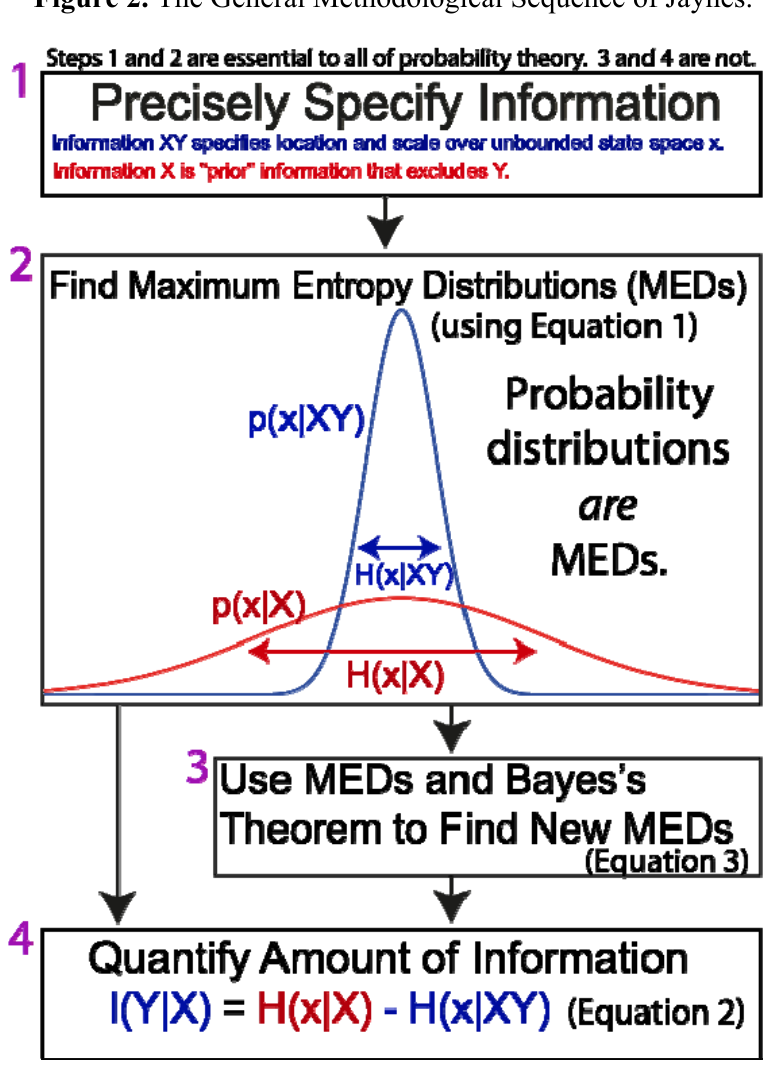
Figure 2. The General Methodological Sequence of